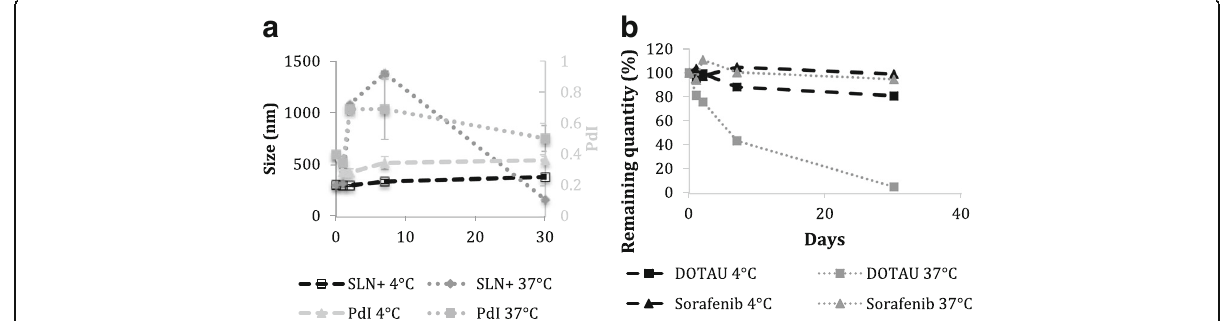
Fig. 3 Stability studies of SLNs. Colloidal stability of SLN + ( a ) and chemical stability of sorafenib and DOTAU in SLN + versus time at 4 and 37 °C ( b ). PDI,